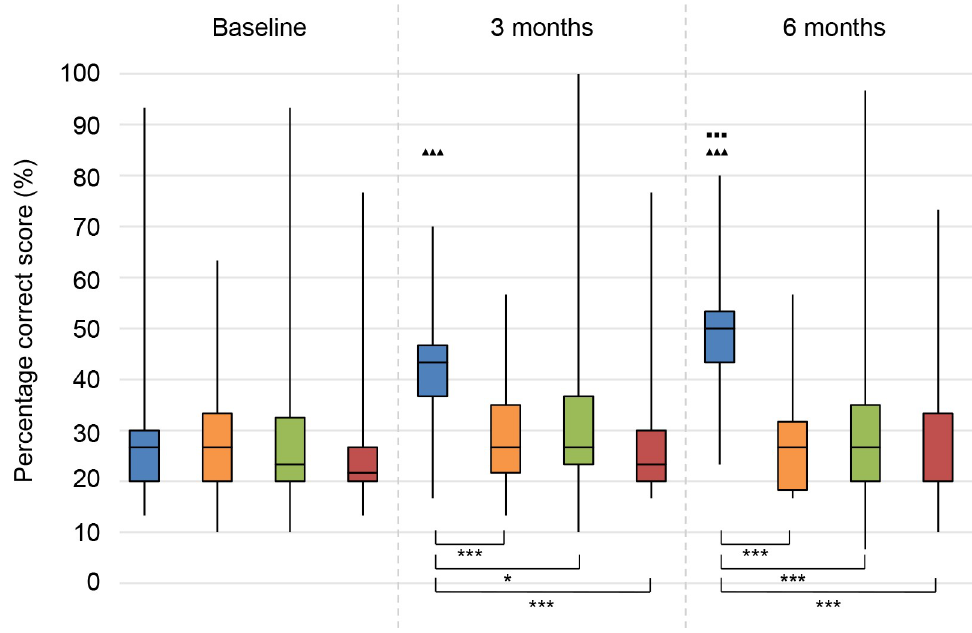
Fig 5. Sound localisation. Sound localisation as a percentage correct score (%) for configuration 15˚ angle between 5 loudspeakers (chance level: 20%). Statistical difference compared to baseline. ▲▲▲ = p < 0.001; ▲▲ = p < 0.01; ▲ = p < 0.05. Statistical difference compared to 3 months follow-up. ■■■ = p < 0.001; ■■ = p < 0.01; ■ = p < 0.05. Statistical difference between groups at same follow-up moment. ��� = p < 0.001; �� = p < 0.01; � = p < 0.05.